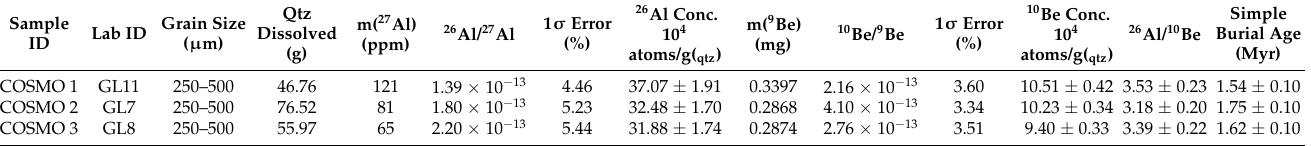
Table 2. Cosmogenic radionuclide information for samples from the stratigraphic layer Geo 2b of Tsiotra Vryssi. Sample Grain Size ID Lab ID ( µ